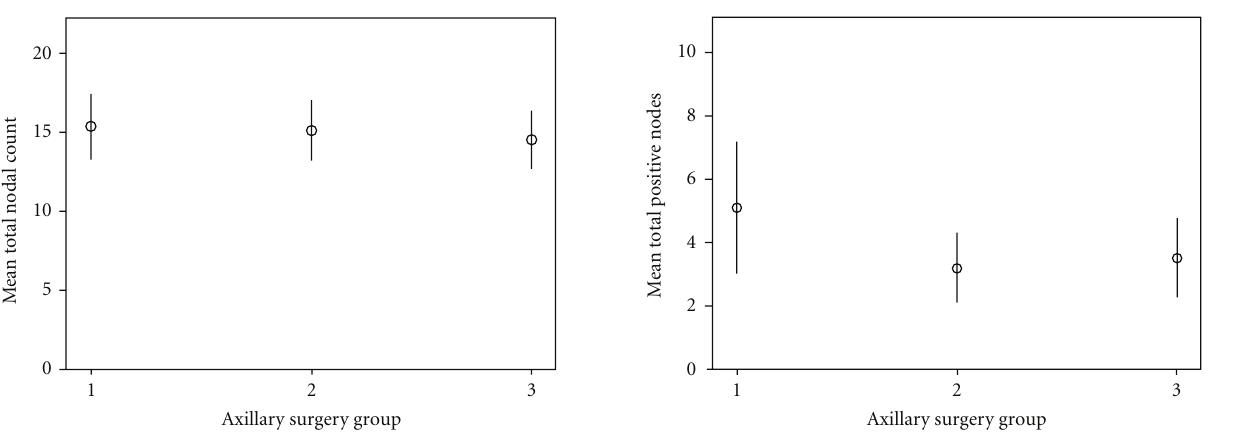
Figure 1: Mean total number of nodes harvested in the three cohorts ( ± 95% confidence interval). Group classification of patients by axillary procedure: group 1: rimary axillary clearance; group 2: SLNB and dALND; group 3: SLNB and iALND.